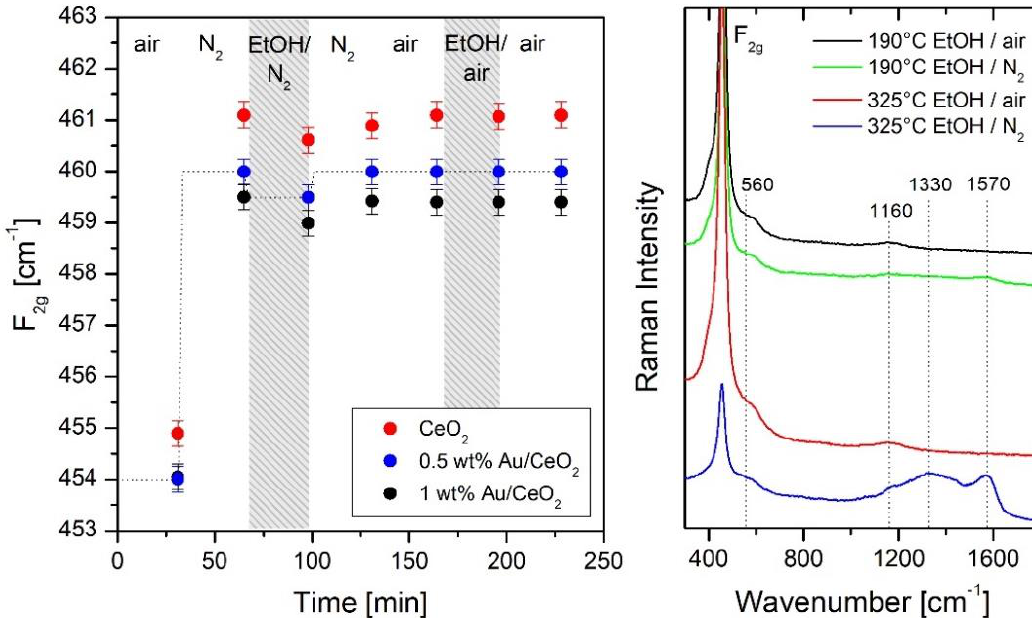
Figure 10. Left: Comparison of F 2g band positions for CeO 2 , 0.5 wt% Au/CeO 2 , and 1 wt% Au/CeO 2 gas sensors in different gas environments at 190 °C after initial calcination in air at 400 °C. The dashed line is a guide to the eye. Right: Raman (514.5 nm) spectra of the ethanol gas sensing by 0.5 wt% Au/CeO 2 . Spectra are offset for clarity. Modified from [36].